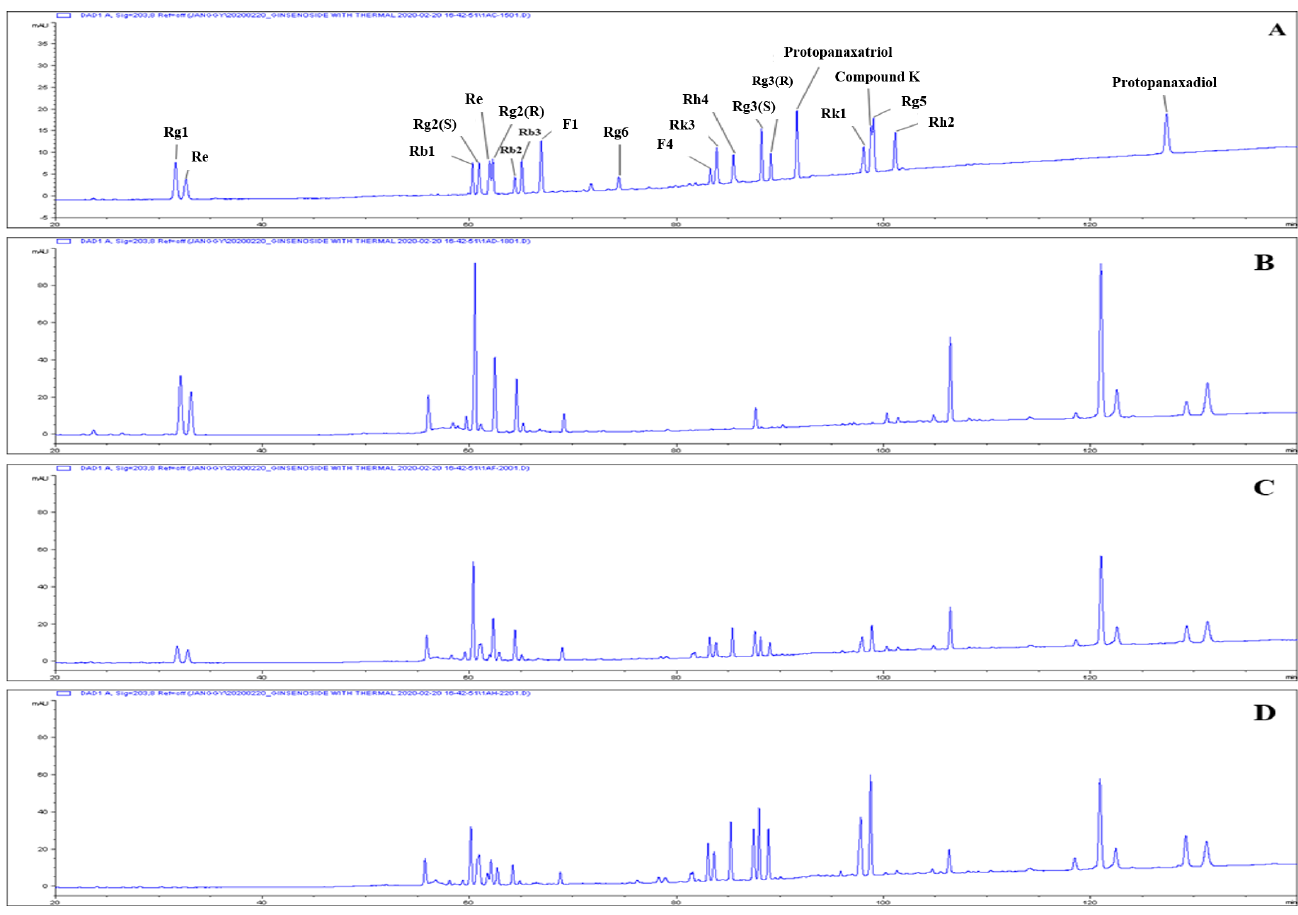
Figure 1. Typical chromatograms of ginseng crude saponin fraction with heat treatment. Samples: ( A ) standards; ( B ) control; ( C ) 90 °C—1 h; and ( D ) 90 °C—2 h.